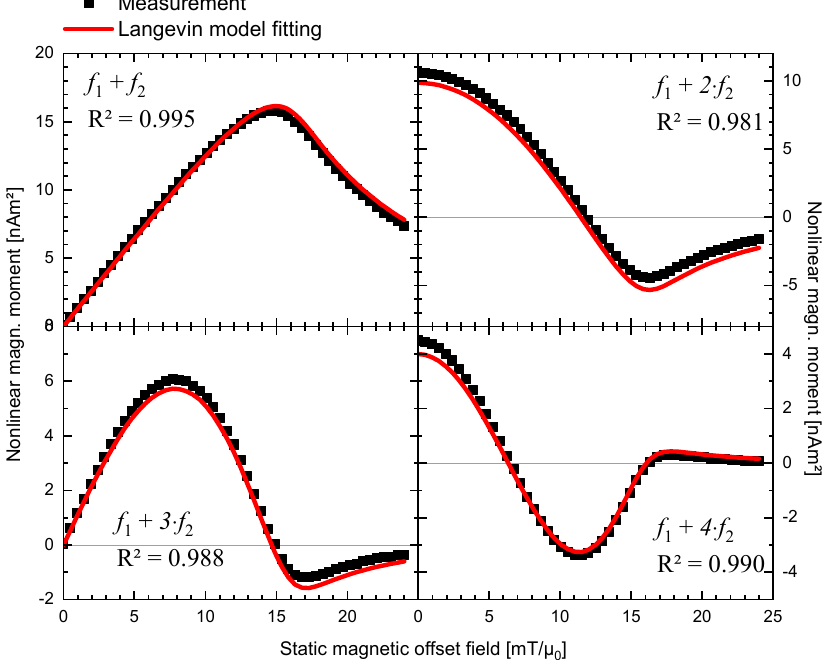
Figure 1. MNP nonlinear magnetic moment for dual frequency excitation at mixing frequencies f LF + n · f HF with n = 1,2,3, 4 from experimental measurement ( H 1 = 1.29 mT/ µ 0 , f 1 = 30,534 Hz, H 2 = 16.4 mT/ µ 0 , f 2 = 62.95 Hz) and fitted with the Langevin model of Equation (10) with the same